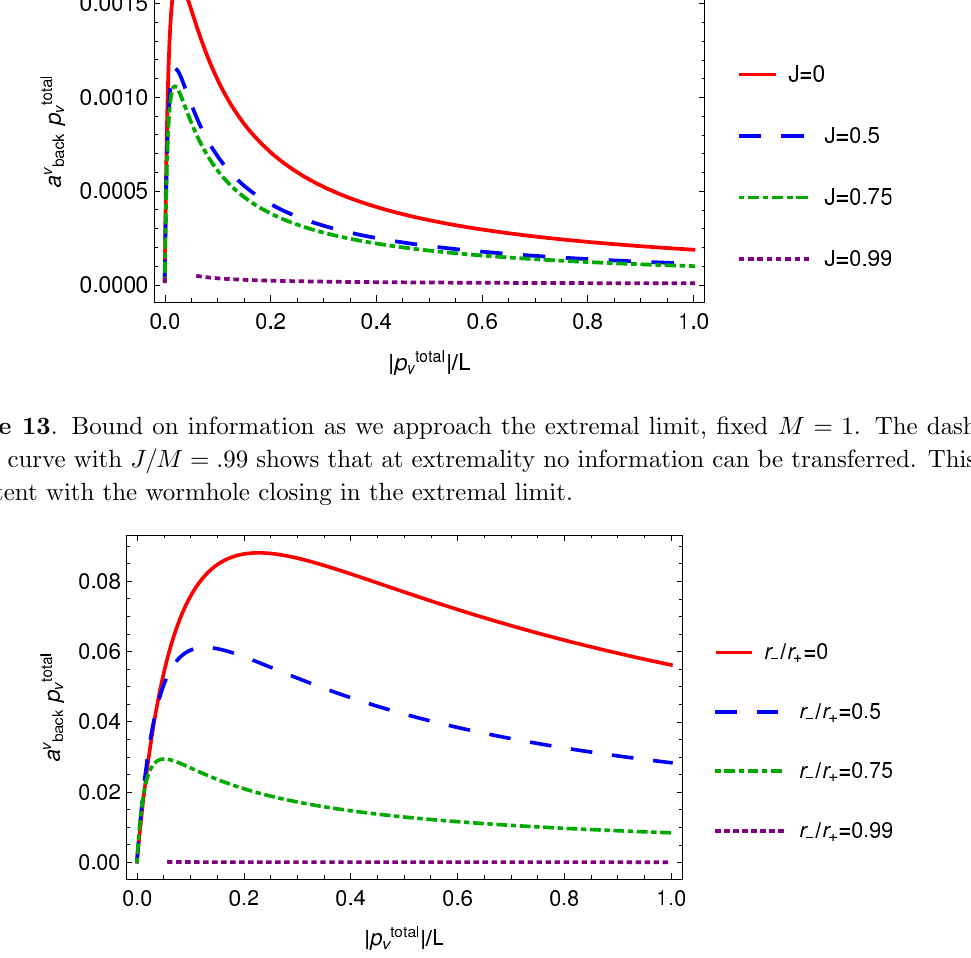
Figure 14 . Bound on information as we approach the extremal limit, (cid:12)xed r + = 1. The dashed purple curve with r (cid:0) =r + = : 99 shows that at extremality no information can be transferred. This is consistent with the wormhole closing in the extremal